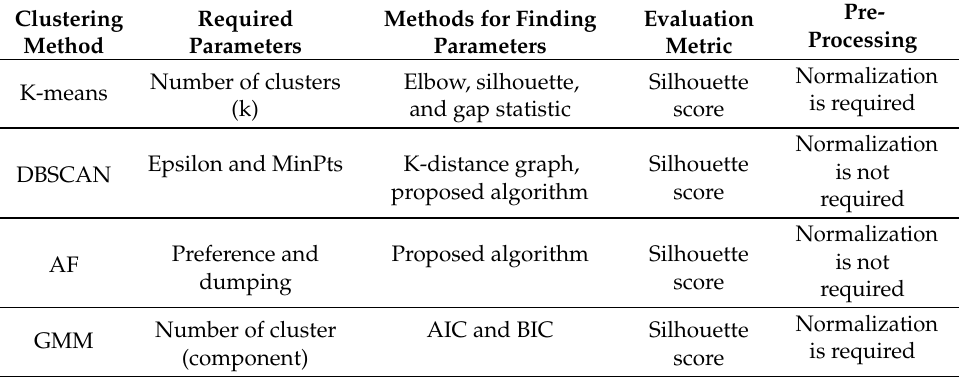
Table 3. Summary of methods used for clustering